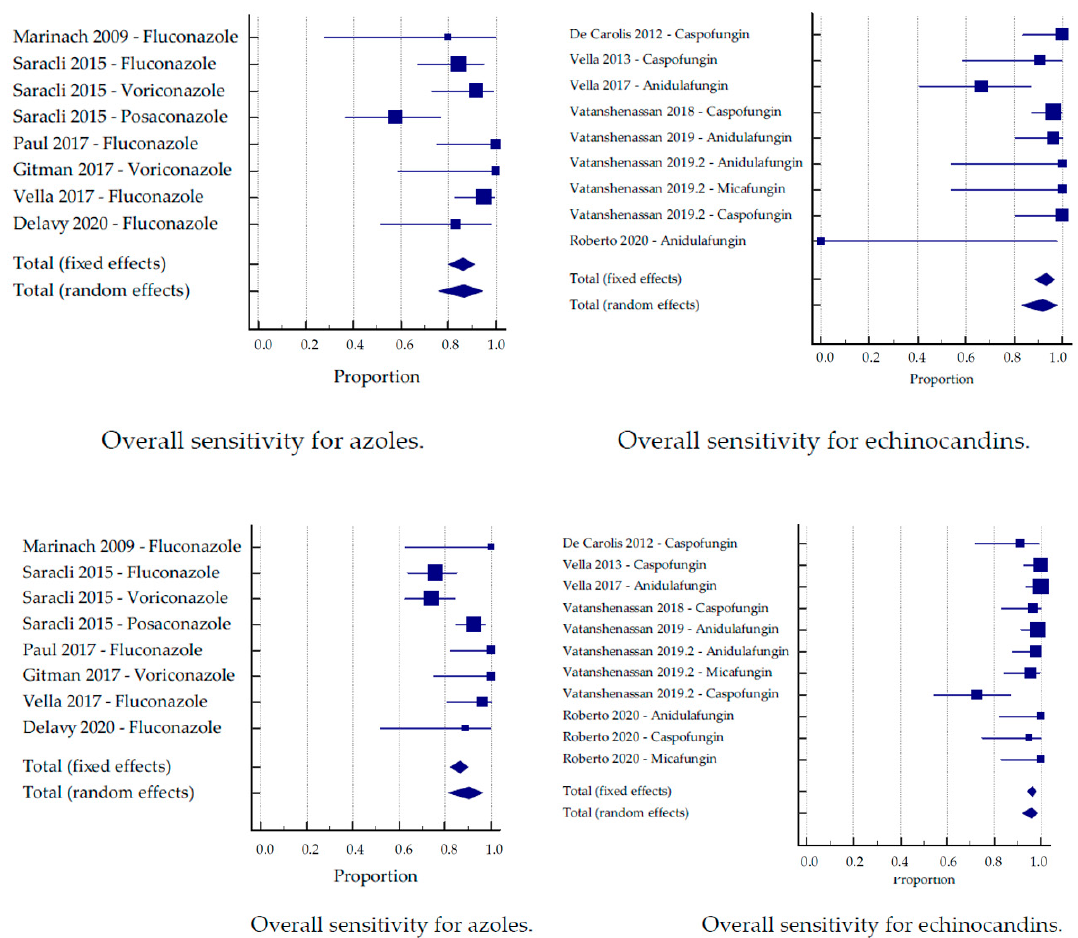
Figure 3. Sensitivity and specificity by the group of the antifungal substance.